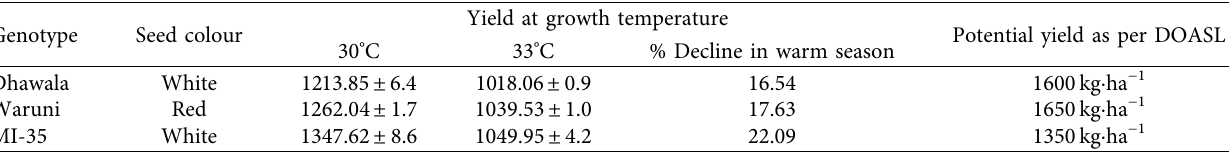
Table 1: Total yields of three cowpea genotypes in two different growth temperatures and average yield potential of three genotypes as reported by the Department of Agriculture, Sri Lanka [28]. Genotype Seed